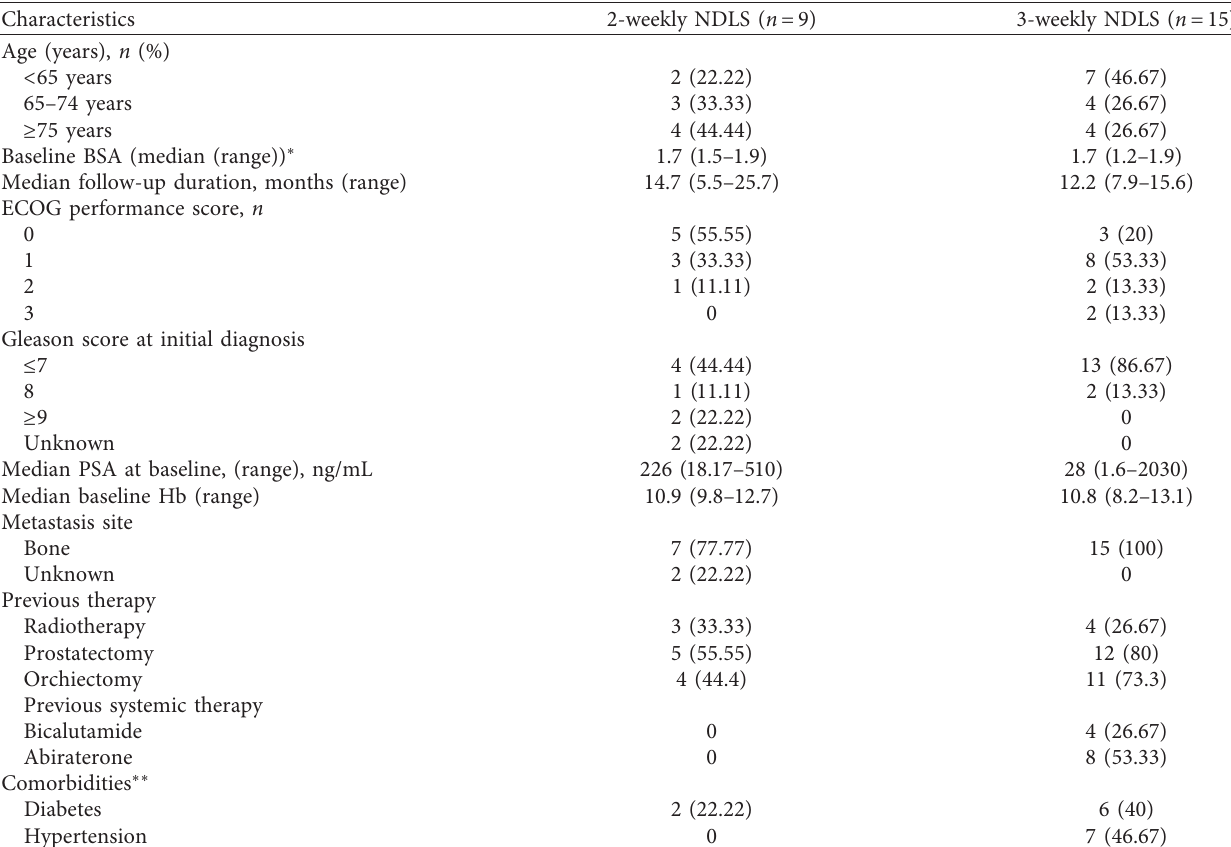
Table 1: Demographic and baseline